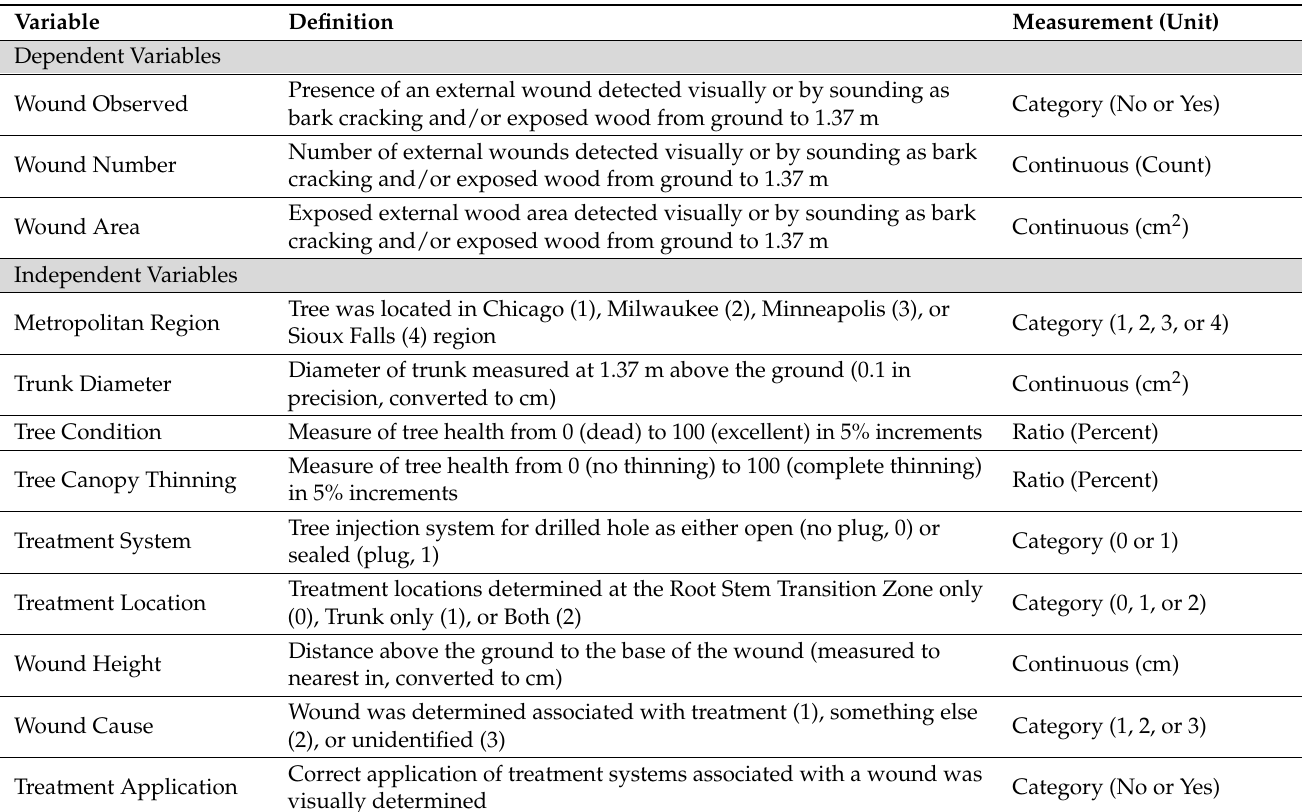
Table 1. Study variables, the definition, and measurement